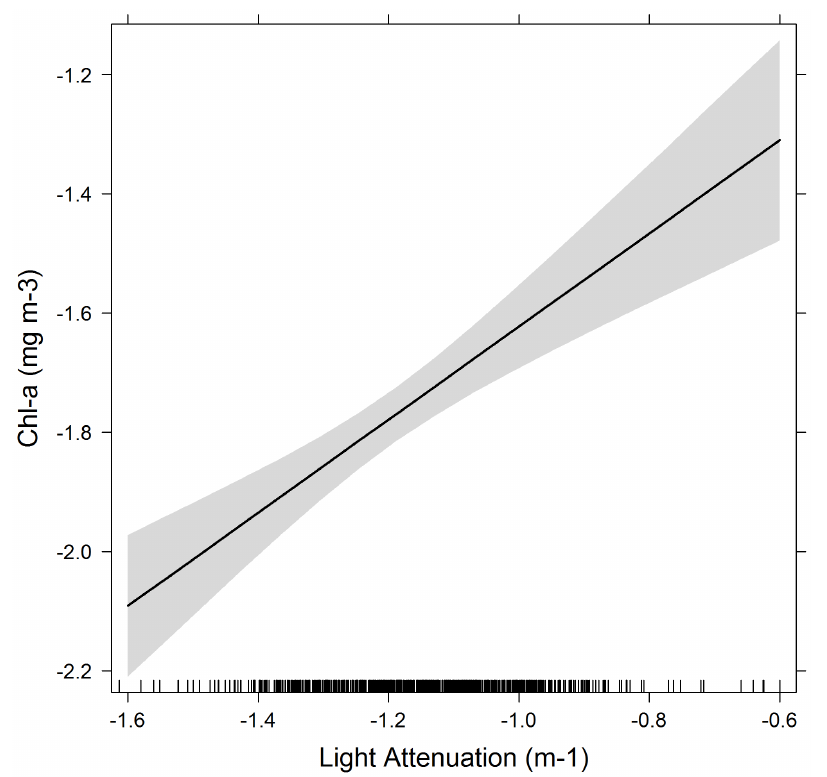
Figure 4. Relationship between chl-a and light attenuation (LA 250 ) from our mixed model. Shaded area indicates the confidence level. Both axes are log transformed.